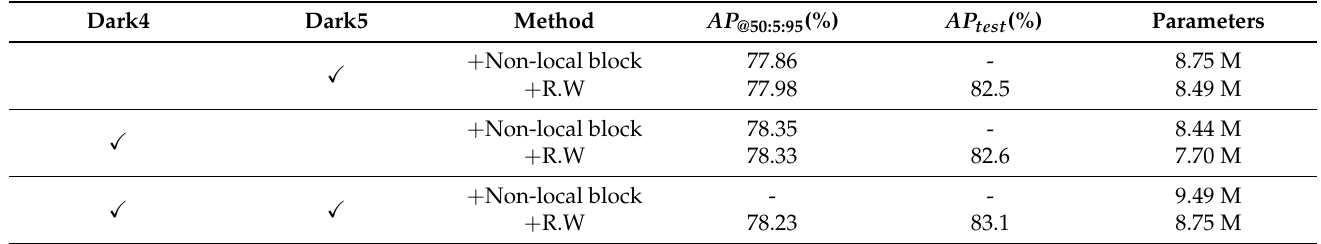
Table 3. Comparison of model accuracy after adding the non-local block, reusing feature maps, and weighting feature